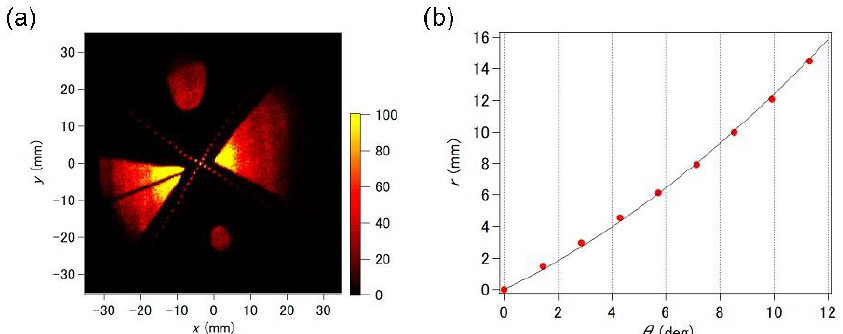
Figure 7. ( a ) An image of the elastic scattering signals of electrons scattered by Ne atoms and passing through the calibration plate at the incident electron kinetic energies of E i = 1000 eV. ( b ) The radius R of the signals measured from ( x ’, y ’) = (0, 0) on the time-and-position sensitive detector as a function of the scattering angle θ at the incident electron kinetic energies of E i = 1000 eV. A black solid curve represents a best-fit curve represented by the second order polynomial expansion of Equation (4).